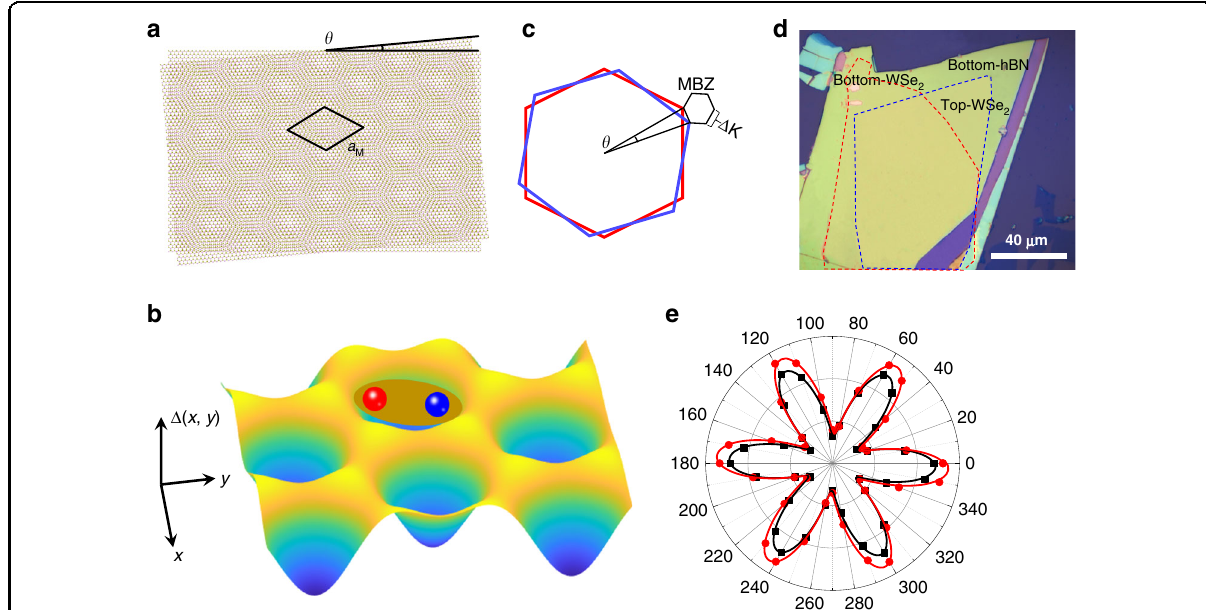
Fig. 1 Optical properties of moiré superlattice in twisted homobilayer. a Schematic depiction of the moiré superlattice structure generated by the WSe 2 bilayer with a twist angle of θ , where a M is the moiré potential period. b The moiré superlattice results in periodic modulation of the electrostatic potential in the twisted homobilayer, which can trap excitons in the periodic potential. c The formation of the moiré unit cell in the twisted homobilayer causes the formation of the moiré Brillouin zone. d Optical image of the WSe 2 /WSe 2 twisted homobilayer placed on hexagonal boron nitride (hBN). The bottom WSe 2 and top WSe 2 monolayer regions are represented by red and blue dashed lines, respectively. e Measured and fi tted the SHG signals of the WSe 2 monolayer area on the top and bottom of the sample to determine that the twist angle between the WSe 2 bilayers is close to zero